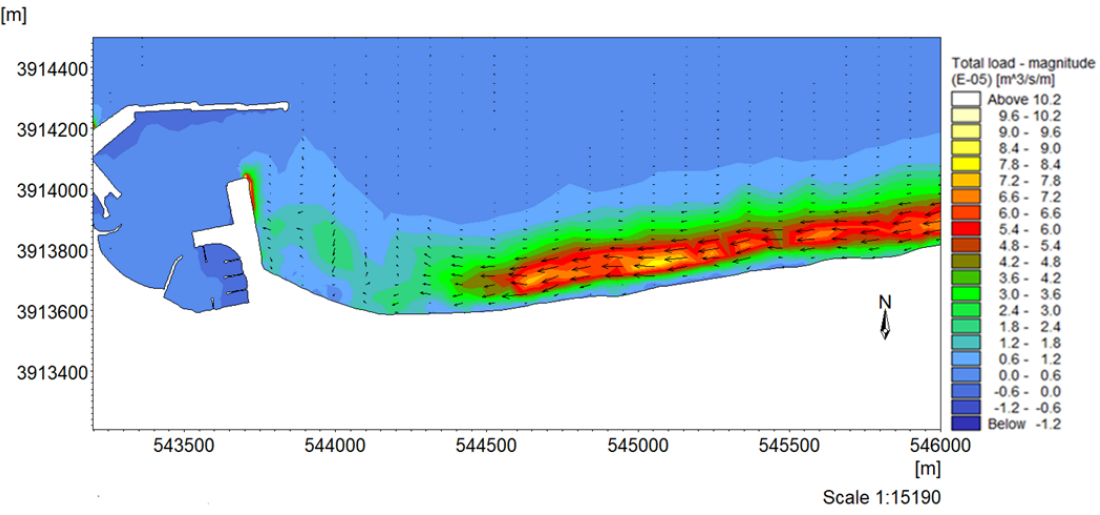
Figure 8. Total load magnitude and direction at the end of the pick-up rate simulation for the area of interest.